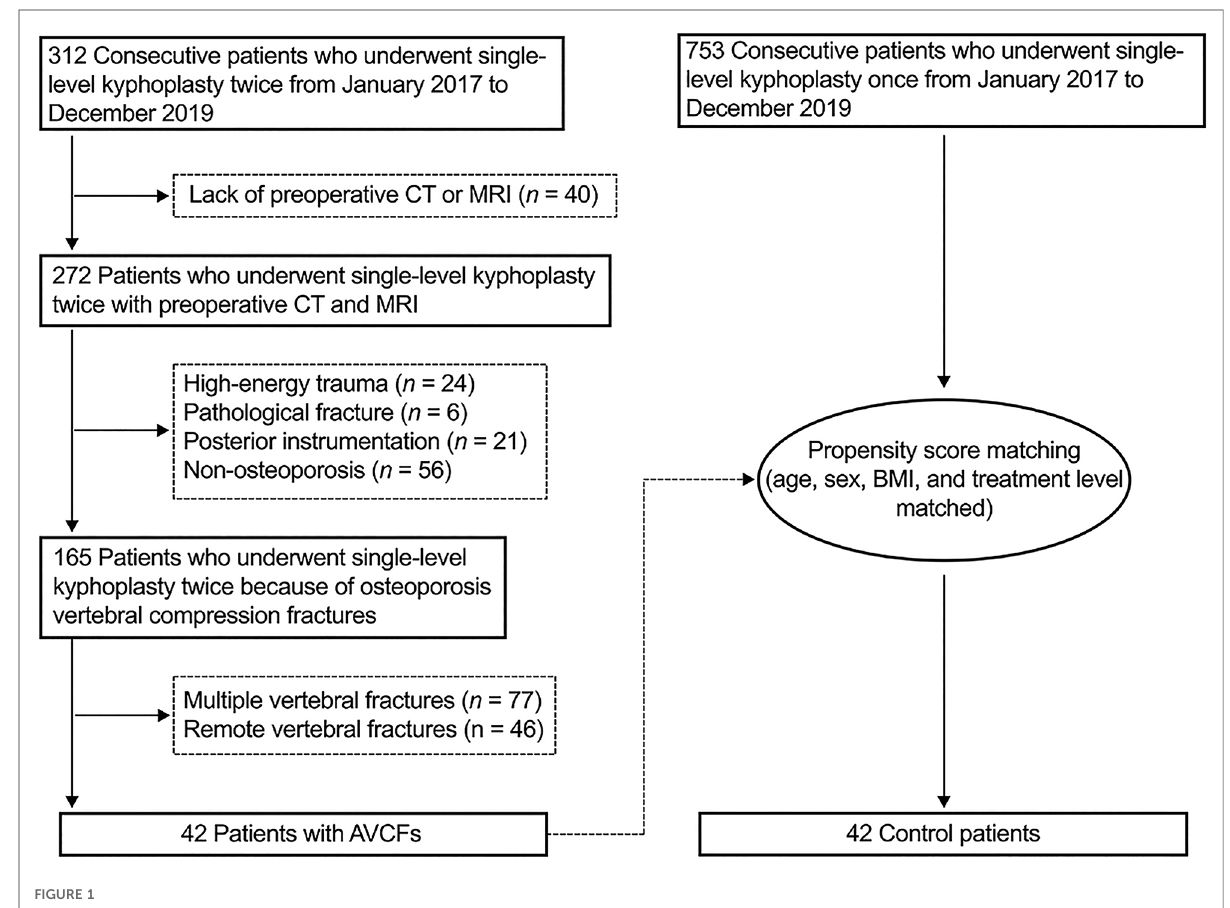
FIGURE 1 Study design fl owchart.